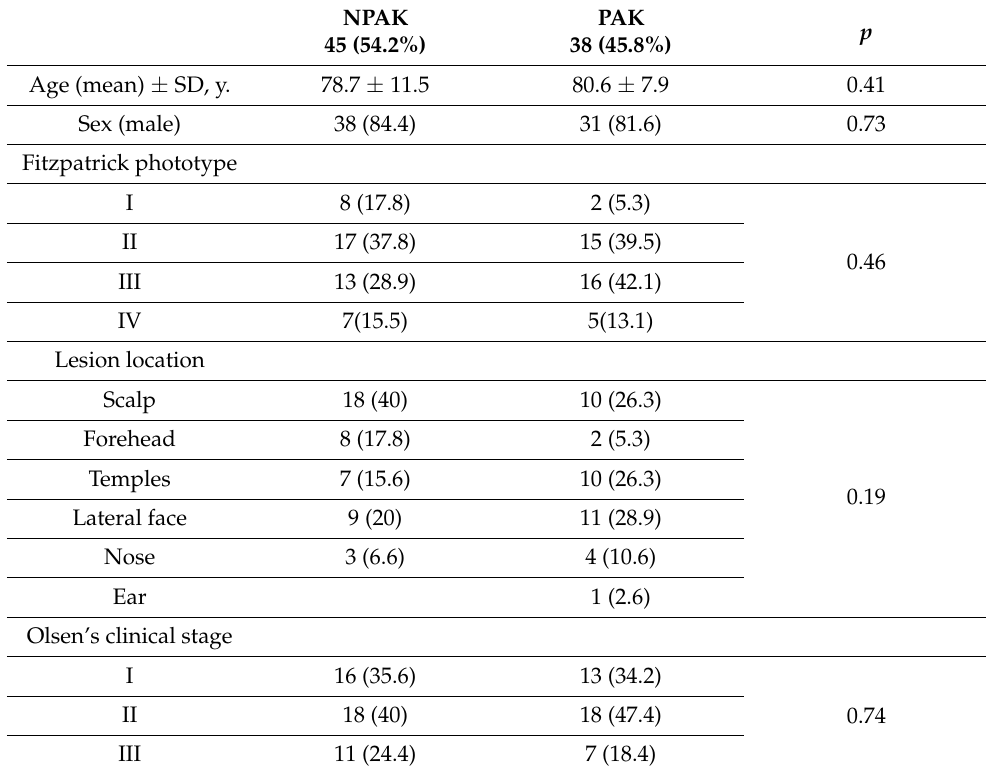
Table 1. Demographic and clinical characteristics of the study’s population.